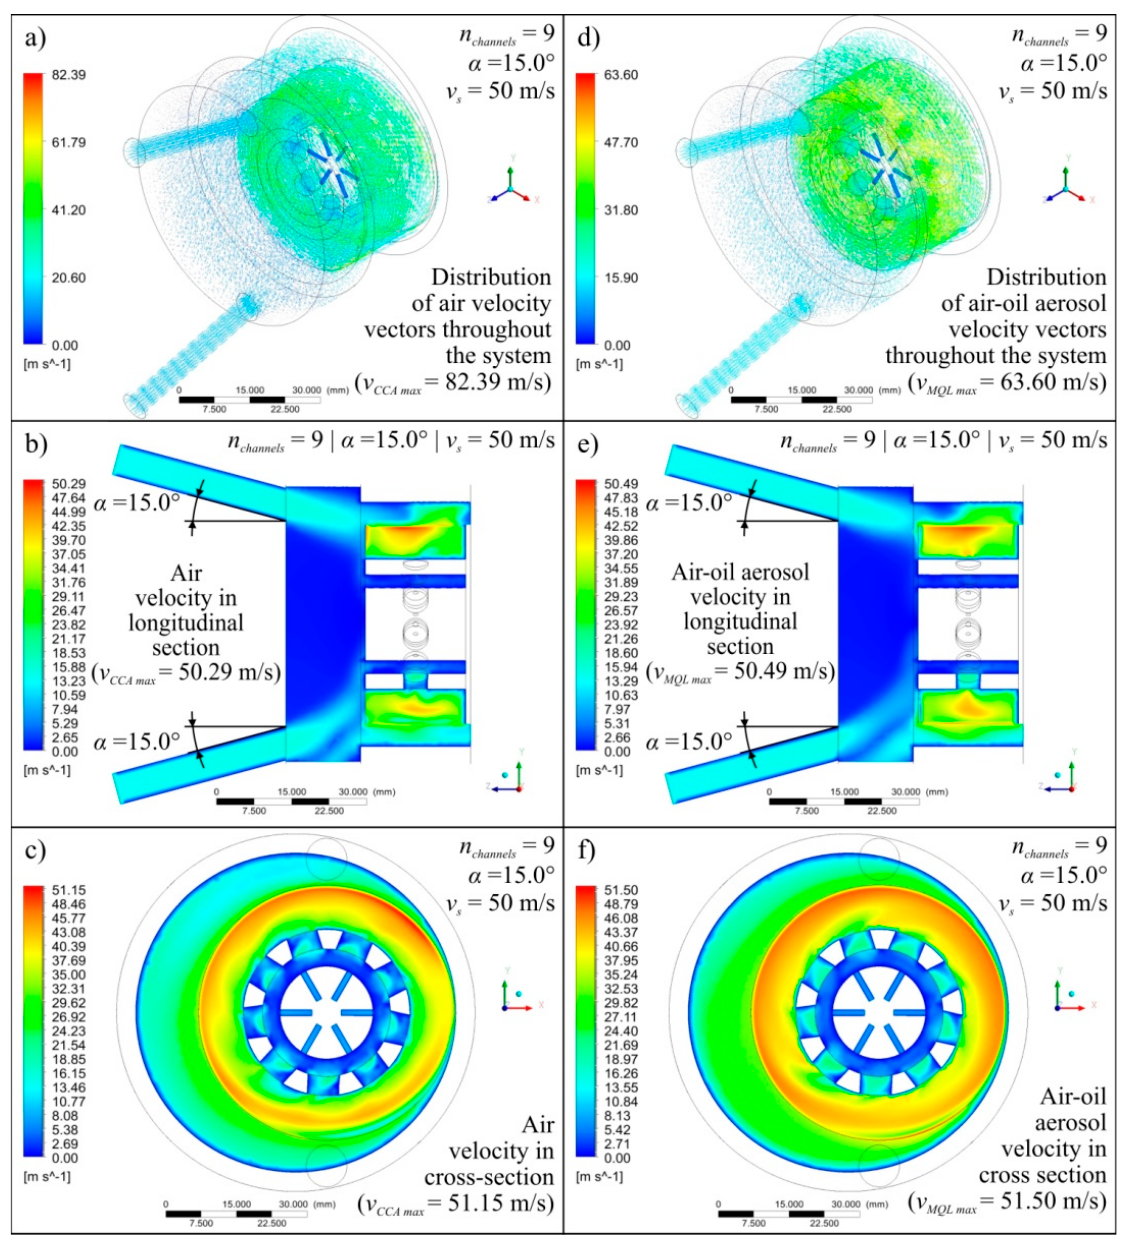
Figure 9. Exemplary simulation results for α = 15.0°, n channels = 9 and v s = 50 m/s presented as colour maps of air flow velocity ( a – c ) as well as oil mist flow velocity ( d – f ) in the entire system ( a , d ), in longitudinal section ( b , e ) and in cross-section ( c , f ).